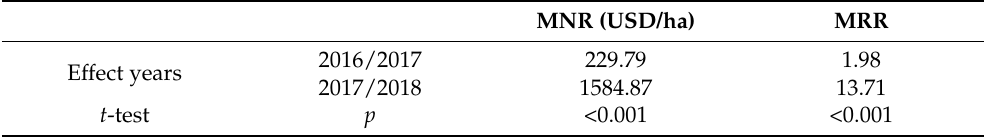
Table 7. Results of the ANOVA for the effect of fertilizer N rate on MNR and MRR and the t -test for the effect of